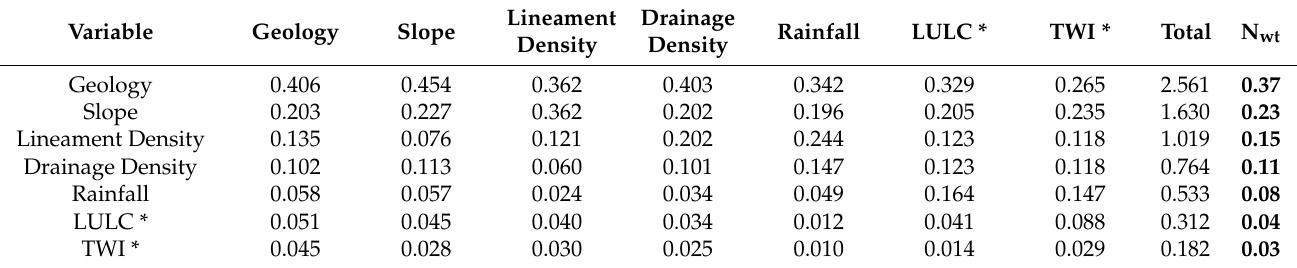
Table 3. Normalized Pairwise Comparison